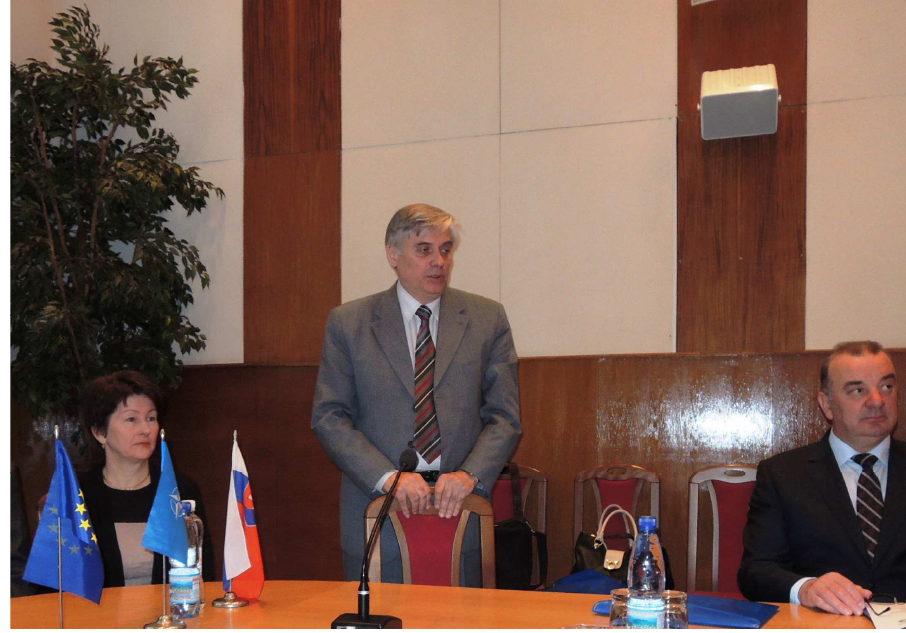
Figure 2. Modest Gertsiuk during chromatographic conferce in Kyiv (2015). The journal publishes articles on the activities of research centers, laboratories, and groups working in this field, and scientists who contribute to the development of chro- matographic research. The Chromatographic Society is a member of the Central European Group for Separation Sciences (CEGSS) and the European Society for Separation Sciences (EuSSS). The participation of the Chromatographic Society in the activities of these organ- izations contributes to the expansion of contacts between Ukrainian scientists/chromatog- raphers and their foreign colleagues and the development of chromatography in Ukraine.